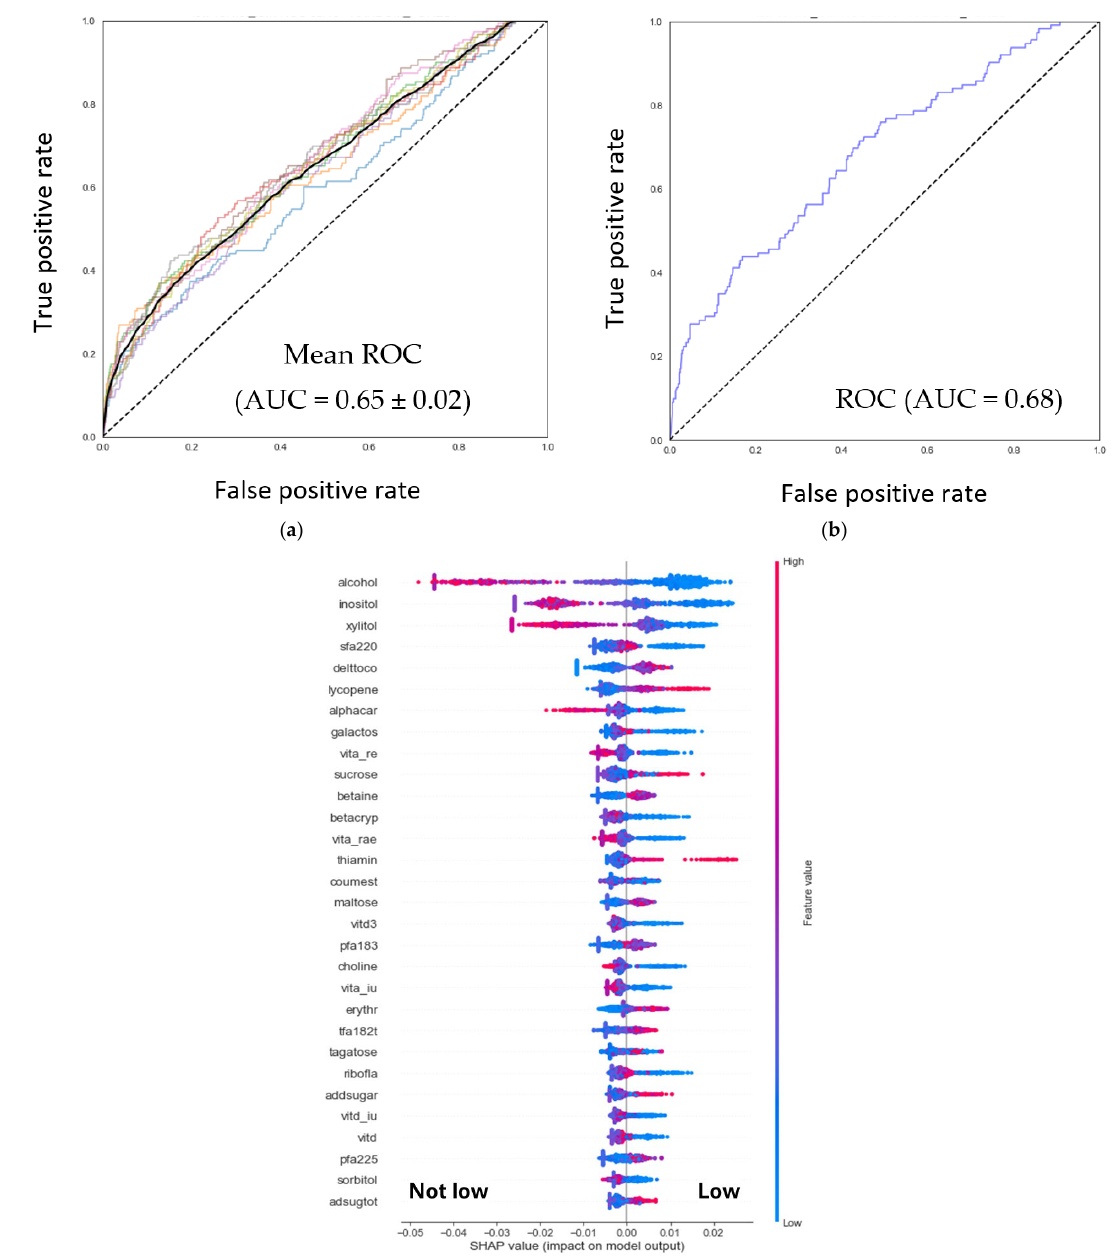
Figure 1. Prediction of relative abundance of F. prausnitzii from nutrient intake data. A random forest model was used to predict the individual’s relative abundance of F. prausnitzii in low or notlow category (<mean—1SD vs. the rest). ROC curves and area under the curve (AUC) values for the training (in cross validation mode with 3 folds, 3 repeats) ( a ) and test ( b ) datasets are shown. Different colors in ( a ) indicate performance under different model runs (3 folds, 3 repeats) and the black line indicates an averaged out Mean performance. Top 30 most important nutrient features of the model are shown in ( c ), where contributions of each nutrient feature to the model was analyzed by SHAP. Each dot represents an individual sample. Red and blue color gradations depict higher and lower value of the nutrient’s intake, respectively. If a feature has red values towards the right of the vertical line at 0.00, this indicates higher values of this feature contribute towards “Low” model output. Vice versa, if a feature has red values towards the left of the vertical line at 0.00, this indicates higher values of this feature contribute towards “notLow” model output.